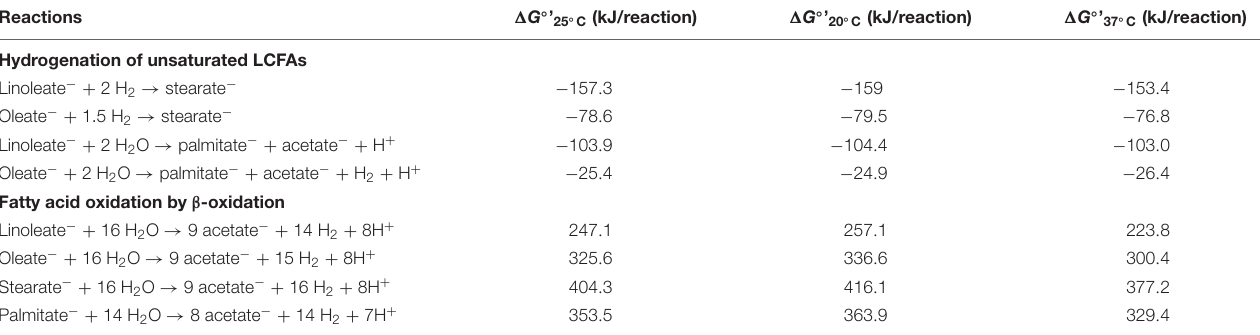
TABLE 3 | Change in Gibbs free energy values of reactions ( (cid:49) G ◦ ’ ) involved in hydrogenation and oxidation of selected LCFAs at standard conditions # . Reactions Hydrogenation of unsaturated